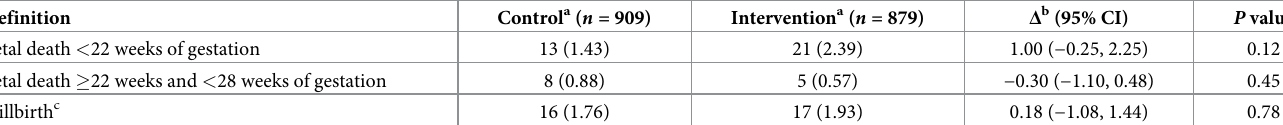
Table 3. Fetal loss and stillbirth prevalence, by prenatal study